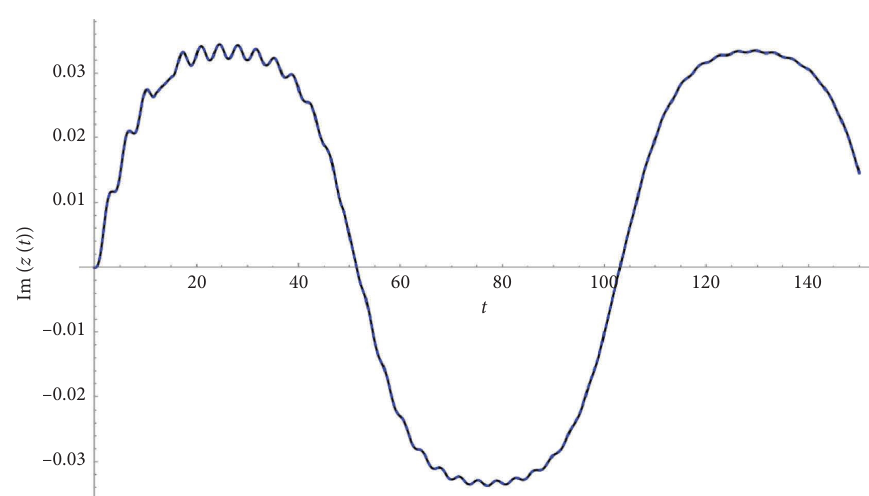
Figure 2: Imaginary part compared with the Runge–Kutta numerical solution.